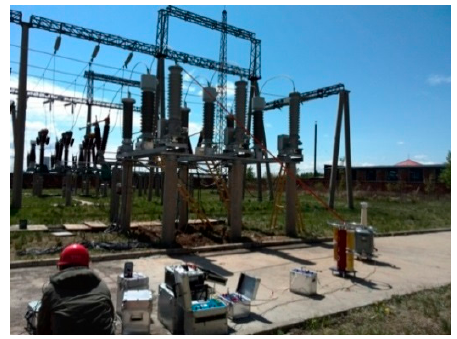
Figure 5. Field off-line accuracy test.